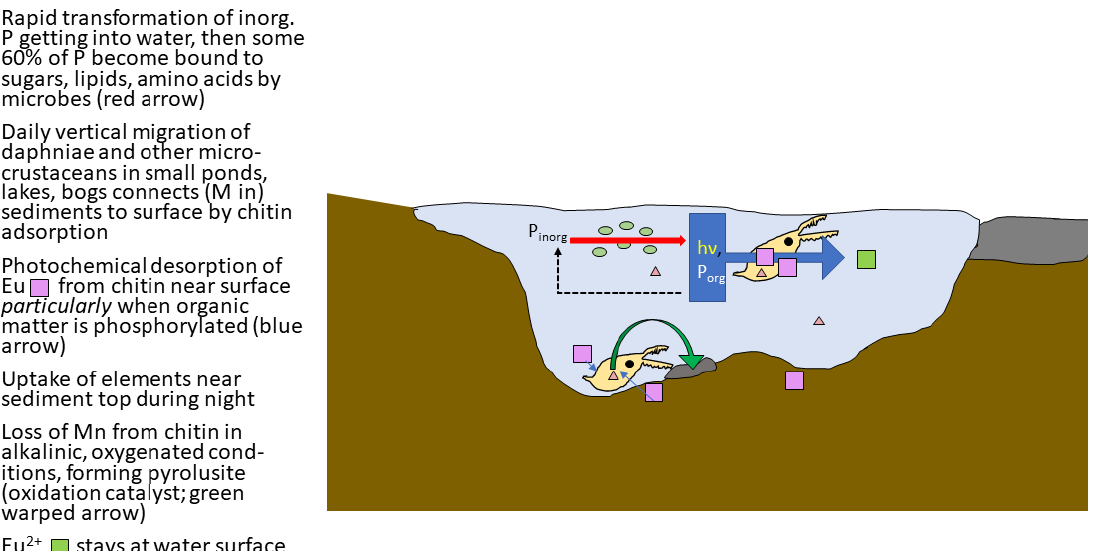
Figure 2. Phosphorus (P) cycling in limnetic biotopes interferes with transport of element by Eu because P-ated dissolved organic matter is much more susceptible to photooxidation by Eu(III) (light pink squares on top (insolated) water flea and in solution)) than others. Phosphorylation is accomplished by (cyano-)bacteria within minutes [28] and partly reversed by the said photooxidation and extracellular phosphatases (broken arrow) (cp. [29]), while Eu 2+ is lost (desorbed, eluted) from Daphnia surface (green square). During night (bottom Daphnia), some part of Mn (rose-colored triangles) is lost in oxidizing conditions to form pyrolusite deposits (black) which in turn oxidize trivalent Cr, Ce, phenols, Cl − , etc. Eu is re-adsorbed from both water (the local levels suffice) and near sediment during night and transported to the surface (top Daphnia in morning (at dawn)).